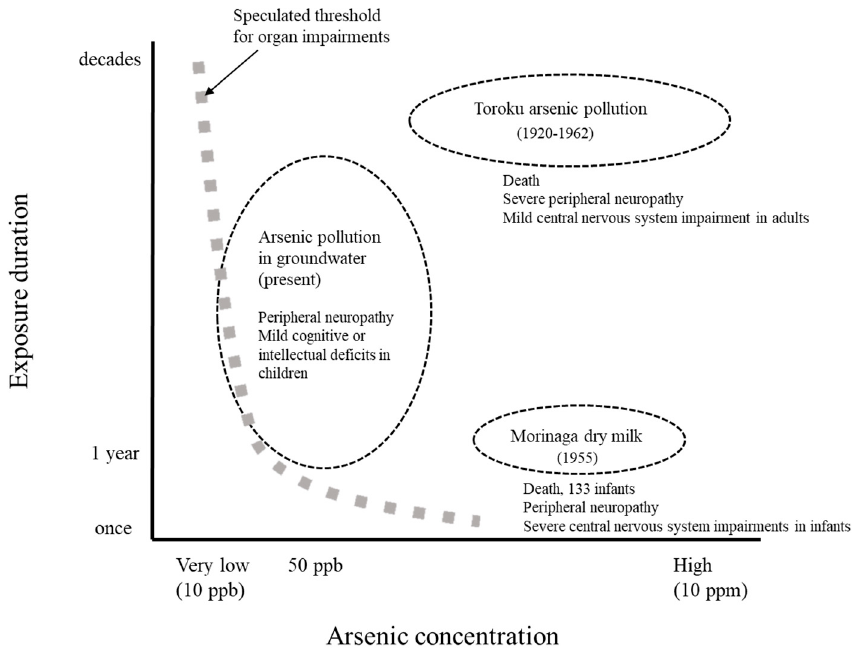
Figure 2. Duration and concentration of As pollution and As exposure incidents. Speculated thresholds for organ impairments are shown as a thick gray dotted line.